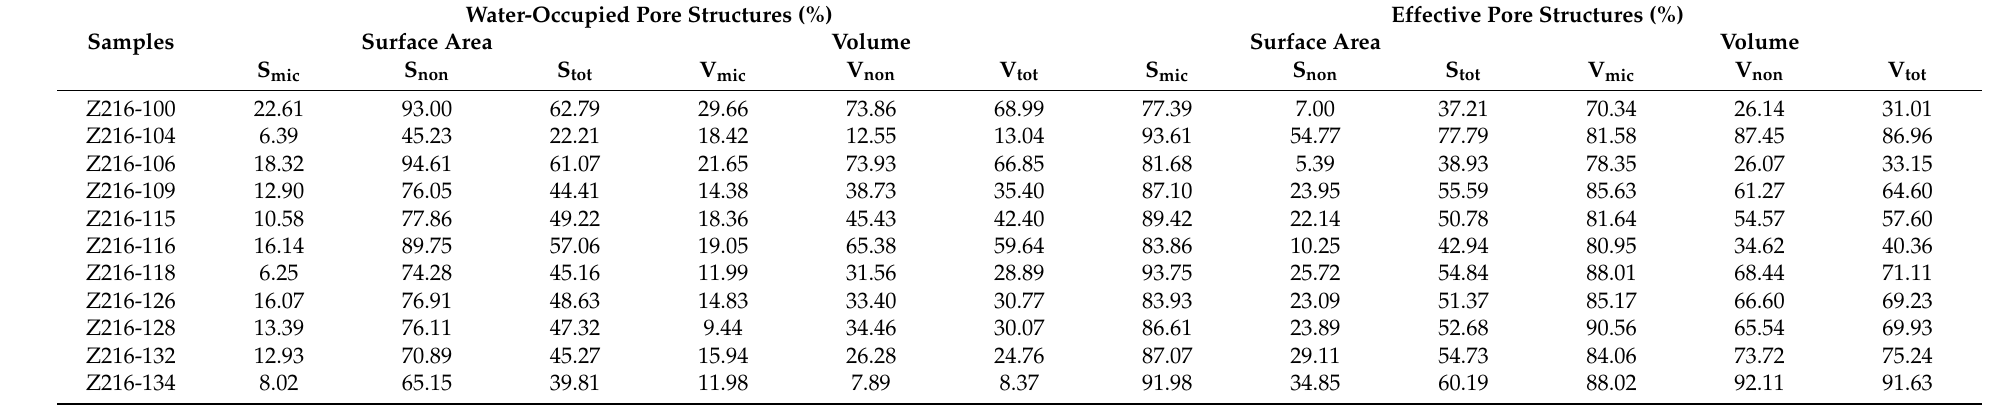
Table 5. Relative percentages of water-occupied and effective pore surface areas and volumes of the studied deep shale samples in the Luzhou Block.